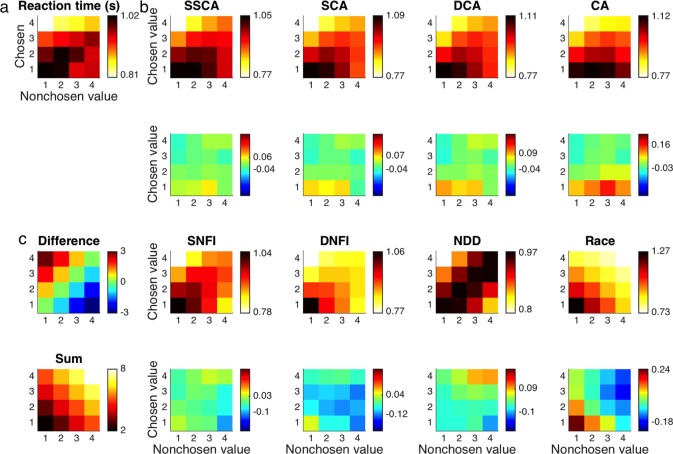
Reaction time.(a) Following the conventions of the previous figure, mean reaction time (RT) as a function of both values is displayed first for the empirical data set. (b) RT is likewise shown for data sets simulated with each of the computational models in the first and third rows. Differences between model predictions and observed results are highlighted in the second and fourth rows. (c) The differences between chosen and nonchosen values and their sums are again provided for reference. The upper-left and lower-right corners of each panel correspond to correct and incorrect choices, respectively, and the diagonal midline between them corresponds to indifferent choices.